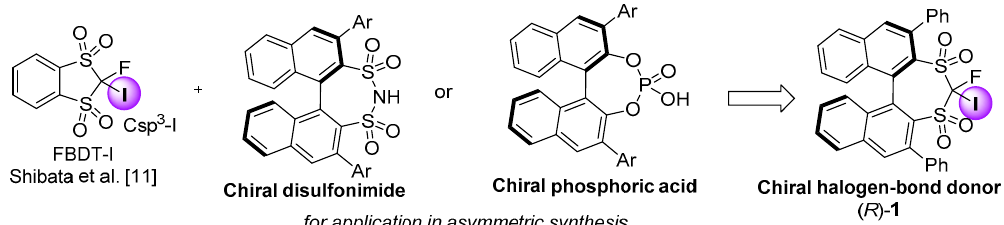
3 -hybridized carbon–iodine moiety . Figure 2. Design of a chiral halogen-bond donor ( R )- 1 with a sp